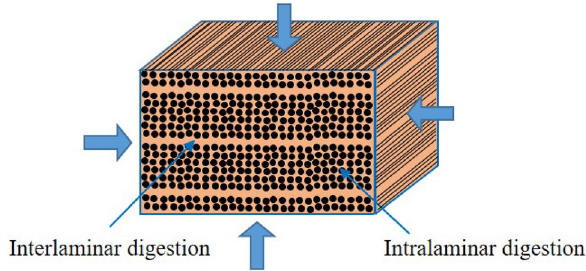
Figure 3. Schematic drawing of digestion in cross-section of composite.